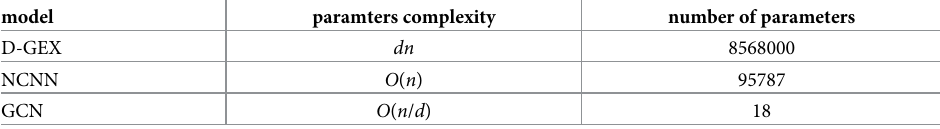
Table 2. The parameter complexity of different models and the number of parameters they actually